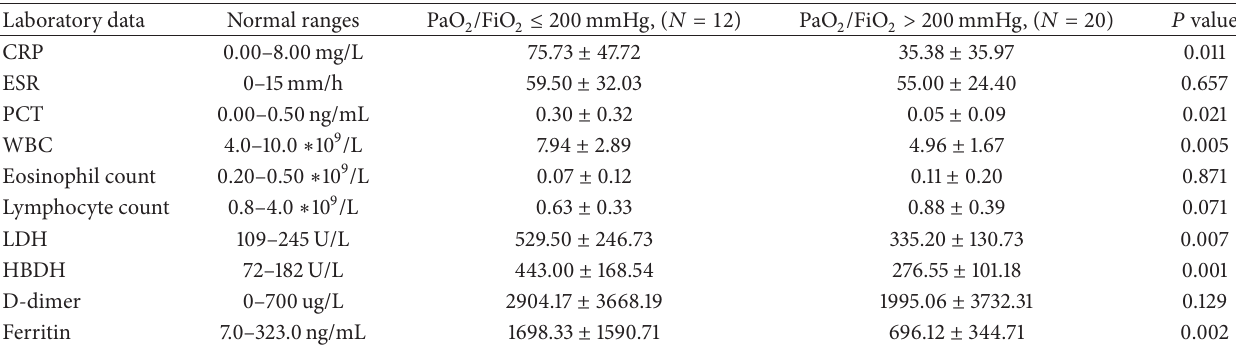
Table 2: Comparisons of laboratory data between PaO 2 /FiO 2 ≤ 200 and > 200mmHg.